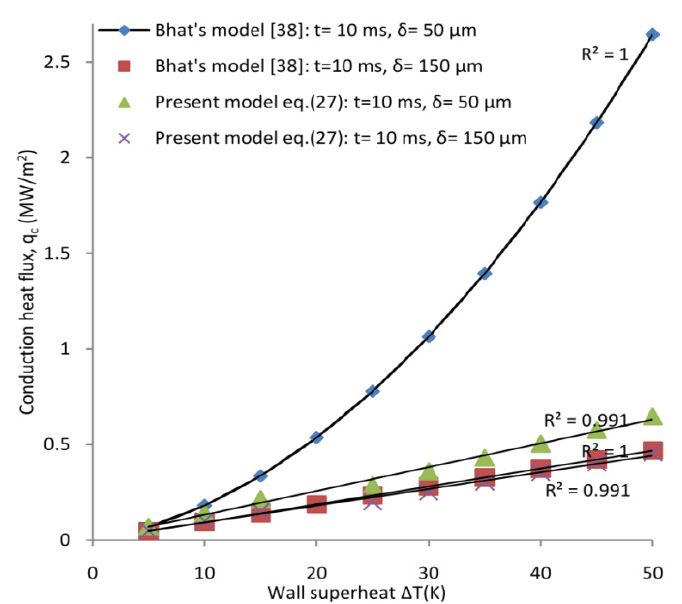
Figure 12. Relativedependence of the conduction heat flux on the wall superheat under constant conditions of time and macrolayer thickness.